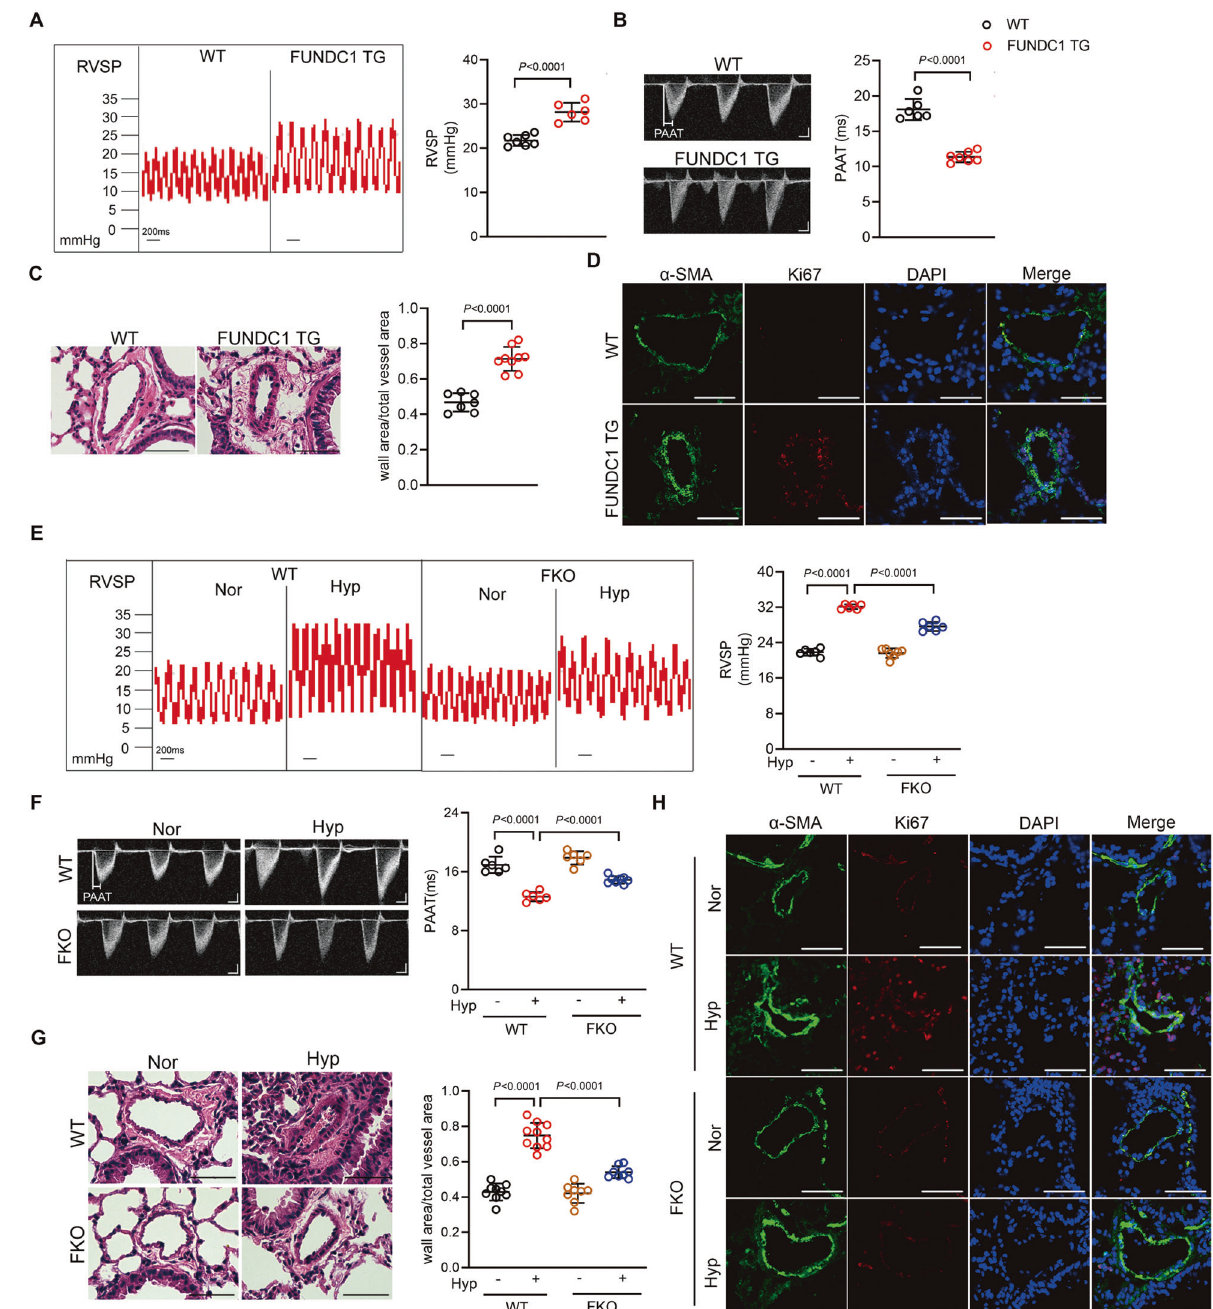
Fig. 5 Increasing mitophagy results in mouse pulmonary hypertension (PH) and inhibition of mitophagy ameliorates mouse hypoxic PH. A Right ventricular systolic pressure (RVSP) and B pulmonary artery acceleration time (PAAT) of wild-type (WT) and Fundc1 transgenic (FUNDC1 TG) mice. n = 6 – 7 mice per group. C The representative pulmonary artery images in the lung sections. n = 7 – 9 mice per group, scale bar: 50 μ m. D Immunostaining of lung sections from WT and FUNDC1 TG mice with indicated antibodies. Green: α -SMA; red: Ki67; and blue: DAPI. scale bar: 50 μ m. E RVSP and F PAAT of WT and Fundc1 knockout (FKO) mice exposed to hypoxia for 3 weeks. n = 6 – 7 mice per group for E , and n = 6 – 8 mice per group for ( F ). G Pulmonary arterial wall thickness and H Ki67-positive cells in pulmonary arteries from WT and FKO mice under normoxia or hypoxia. n = 8 – 10 mice per group for G , scale bar: 50 μ m. Data are presented as mean ± SD. Two-tailed unpaired Student ’ s t test and one-way ANOVA were used to compare two and multiple groups. Bonferroni post hoc analysis were carried out after